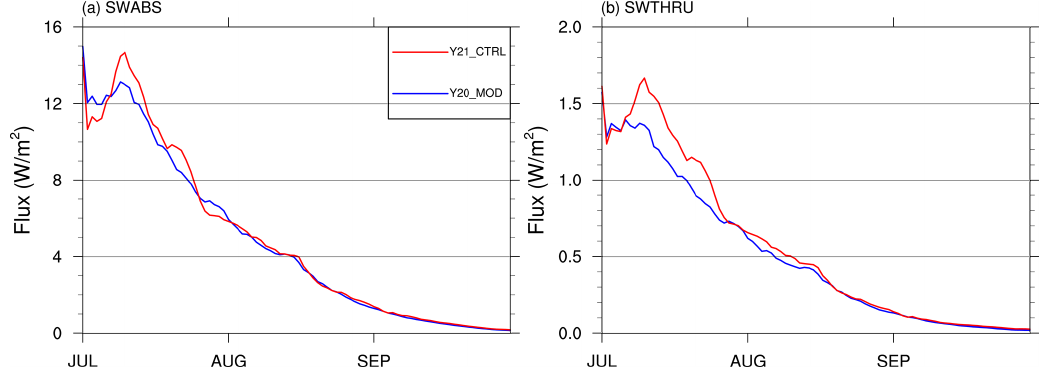
Figure 7. Time series of (a) shortwave radiation absorbed by ice surface and (b) penetrating shortwave radiation to the upper ocean averaged over ice-covered grid cells for Y20_MOD (blue line, the original CAPS) and Y21_CTRL (red line, changes in the atmospheric